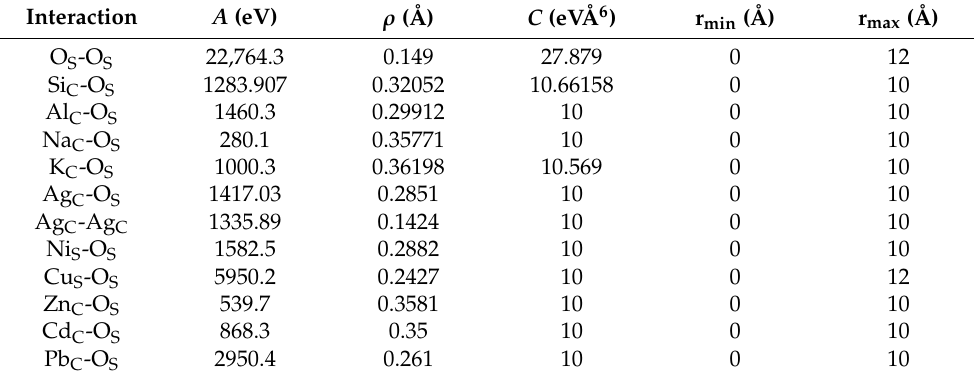
Table 3. Parameters of the Buckingham potentials used in this work.